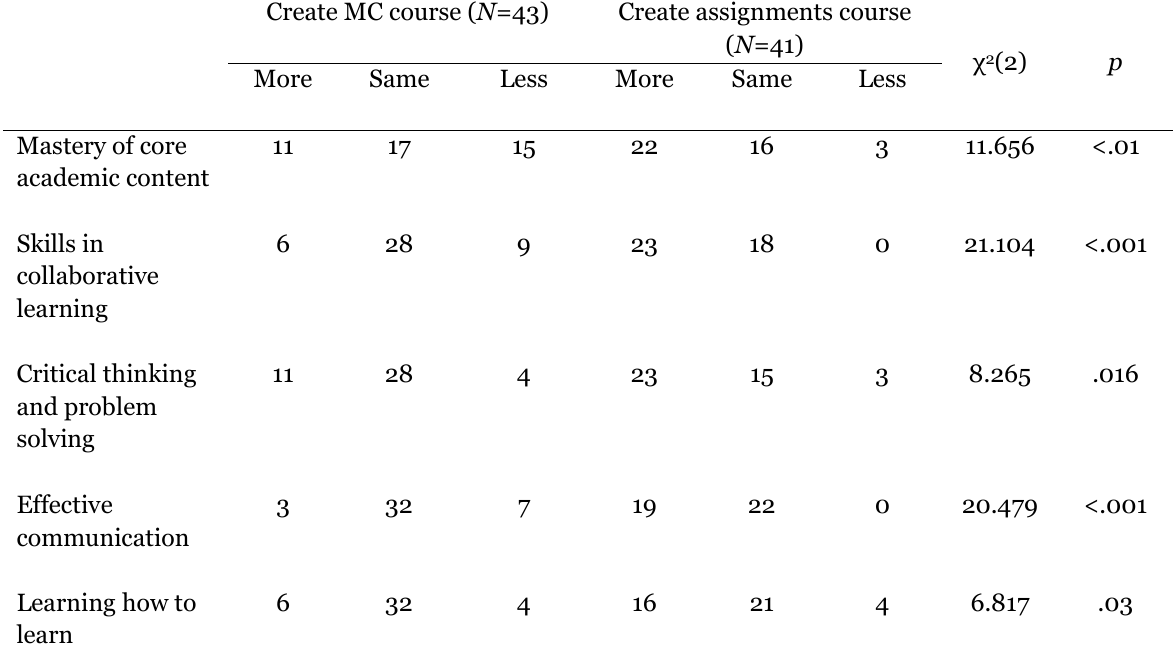
Frequencies and Chi-Square Results for Student Perception of the Efficacy of Two Open Pedagogy Methods Compared to Traditional Learning Activities Create MC course ( N